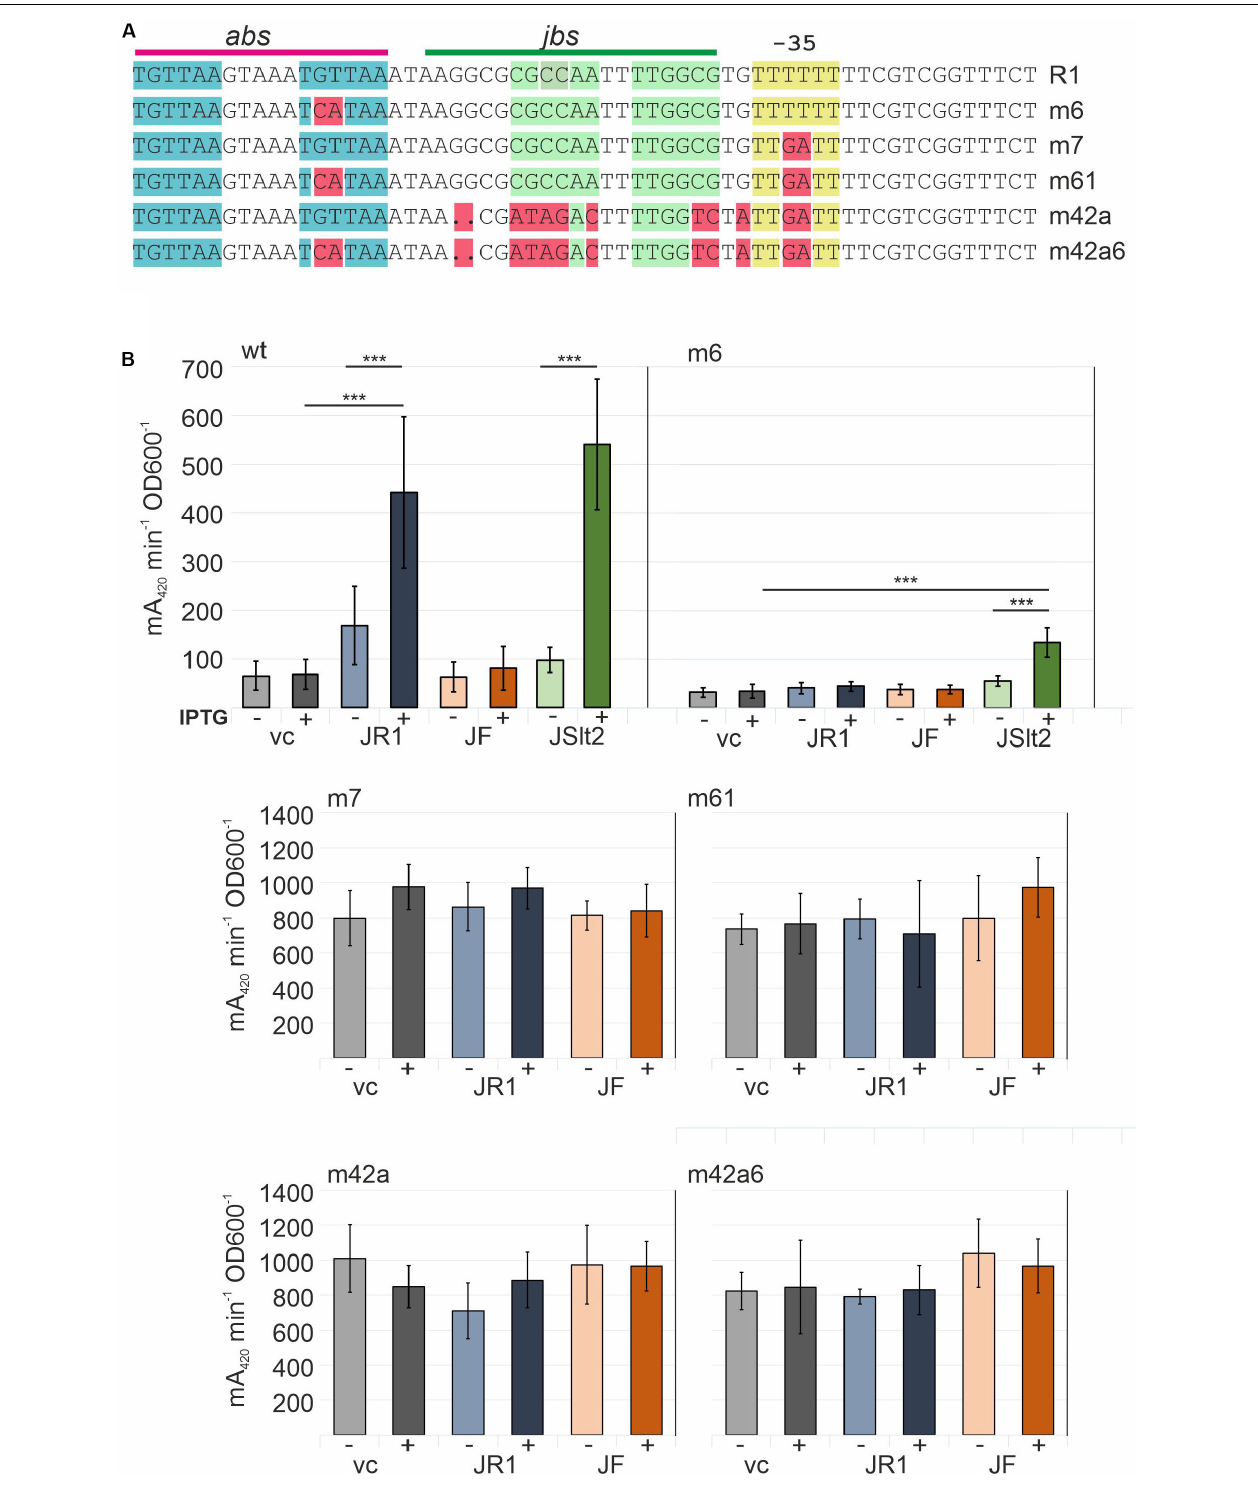
FIGURE 7 | Determination of the role of abs and the non-canonical − 35 region in the R1P Y promoter. (A) Top line shows the R1P Y wt sequence with the abs and jbs sites indicated above. Mutations tested in β -galactosidase assays are shown in the R1P Y sequence context and highlighted in red. (B) β -Galactosidase assays with bacterial cells harboring a R1P Y - lacZ promoter-test plasmid and a second compatible plasmid IPTG-inducible for expression of traJ from plasmids R1 (JR1), F (JF), or pSLT (JSlt2). vc: vector control (no traJ ). IPTG (inductor): +(added), -(not added). Mean values and standard deviations were calculated from at least three independently carried out experiments with two technical replicates for each experiment. P -values (paired t -test): *** P < 0.001.